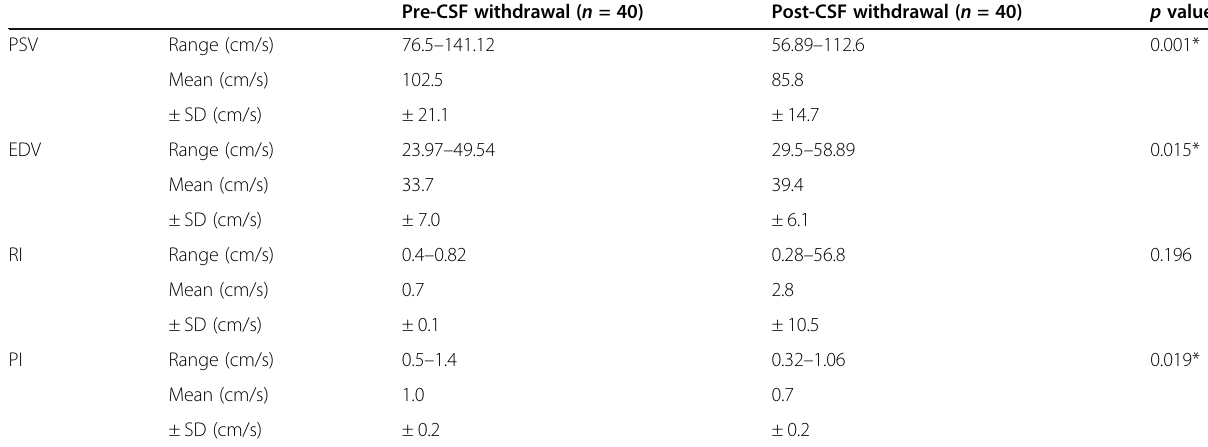
Table 4 Comparison between TCD parameters pre- and post-CSF withdrawal Pre-CSF withdrawal ( n =